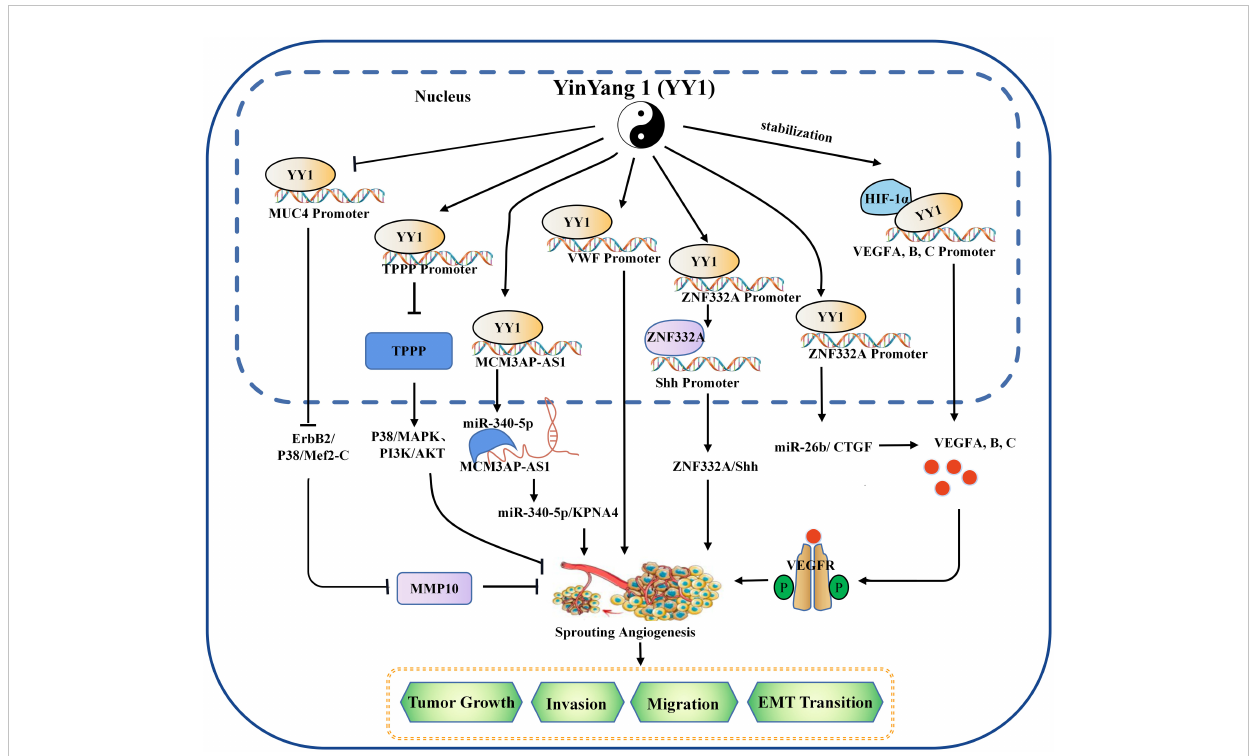
FIGURE 1 The mechanism of YY1 regulating angiogenesis in the tumor microenvironment. YY1 regulates the expression of crucial proteins associated with tumor neovascularization (such as SNHG5, VWF, MUC4, ZNF332a, TPPP, MCM3AP-AS1, VEGF family, et al.), by interacting with their promoters, thus to regulate the proliferation, migration, invasion, and EMT transition of cancer cells in an oncogene or tumor suppressor role. YY1, Yin Yang 1; HIF-1 a , hypoxia-inducible factor 1- a ; VEGF, vascular endothelial growth factor; VEGFA, vascular endothelial growth factor A; TPPP, tubulin polymerization promoting protein; MMP 10, matrix metallopeptidase 10; EMT, epithelial-mesenchymal